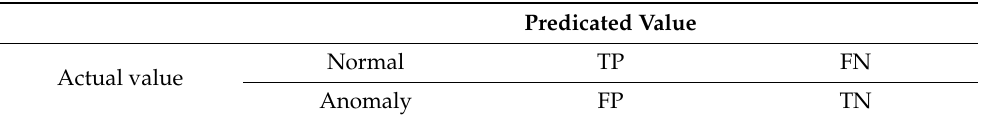
Table 4. Overview of the confusion matrix.